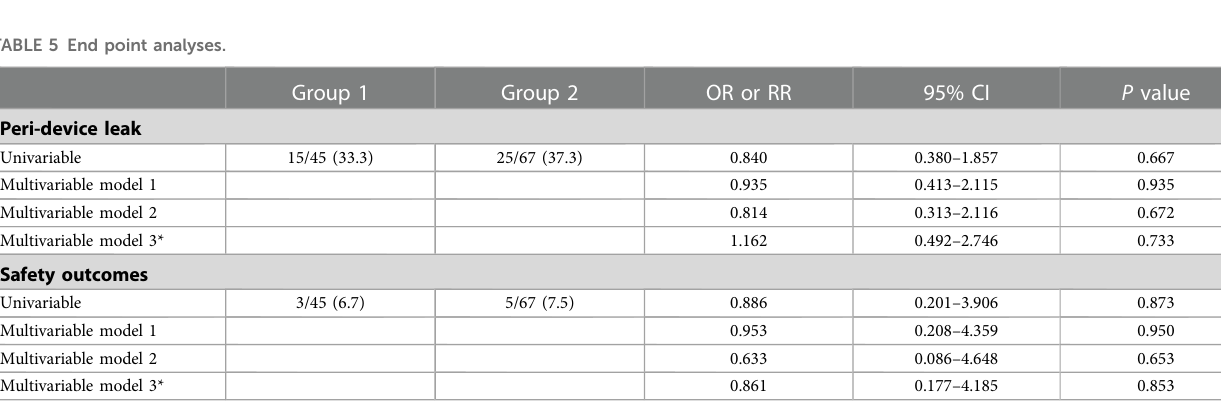
TABLE 5 End point